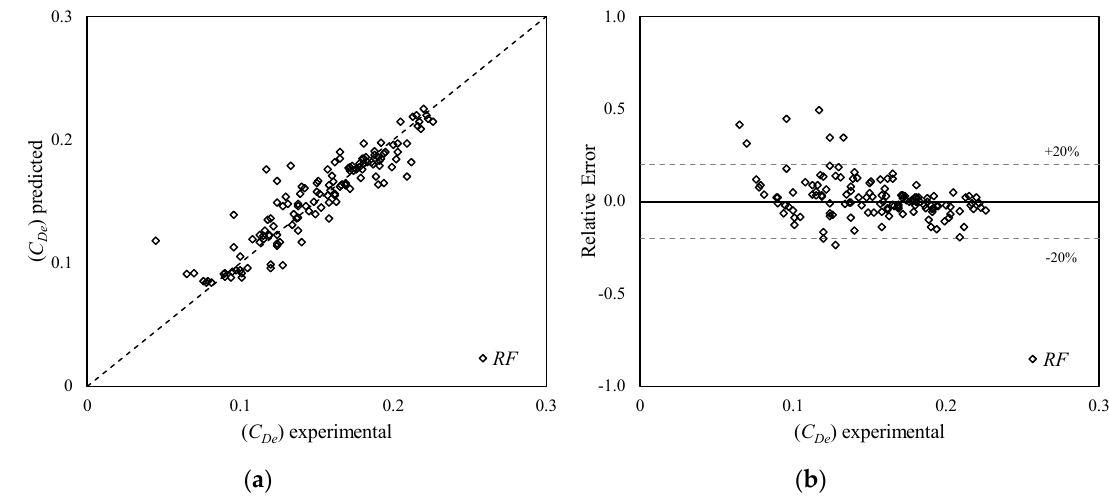
Figure 11. Model 2, RF algorithm, ( a ) predicted versus experimental results, and ( b ) relative error versus experimental results.